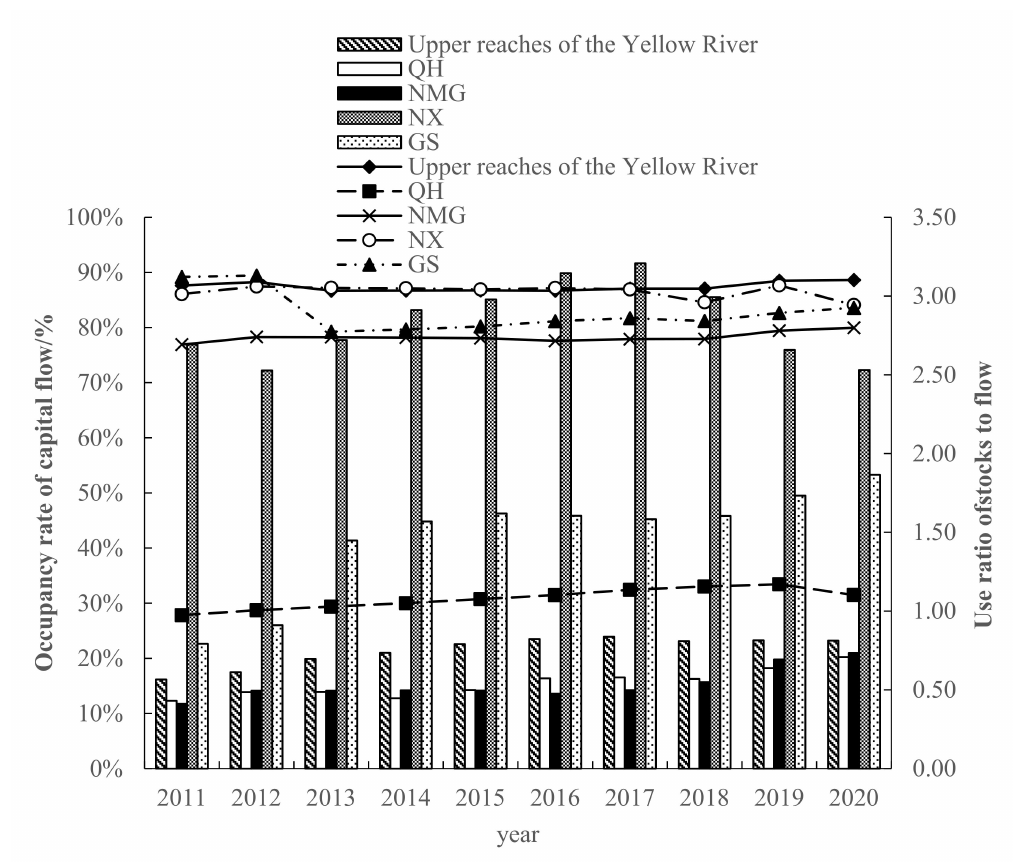
Figure 7. Changes of occupancy rates of capital flows and use ratios of stock-flows in upper reaches of the Yellow River from 2009 to